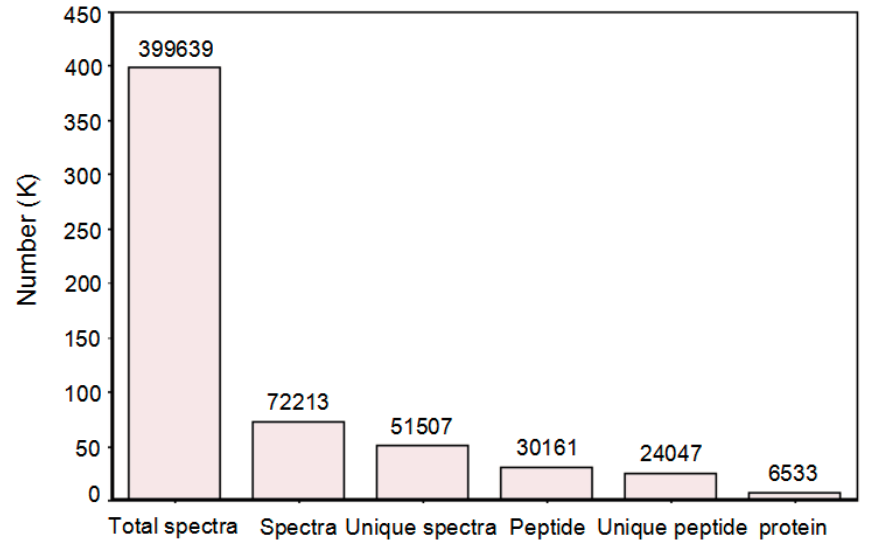
Figure 2. Basic statistics of identified proteins.